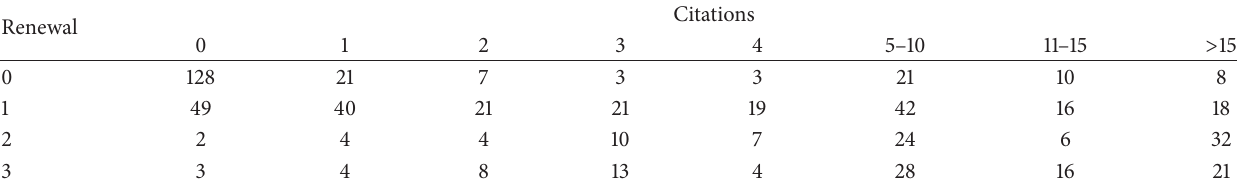
Table 1: Renewal and citation records of the fuel cell technology